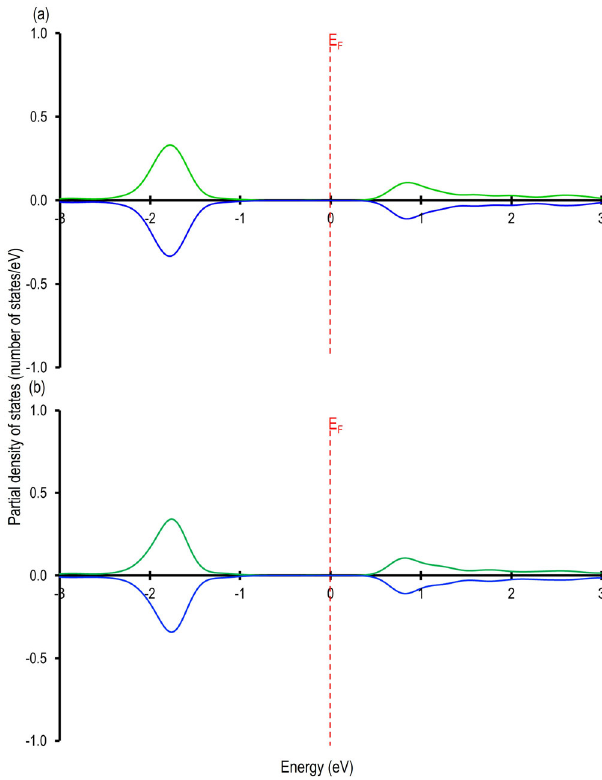
Fig. 5 Partial density of states of Ag-adatom. Partial density of states for Ag-adatom on the 12 membered Si-ring of the ( a ) Si(111)-5×5 and ( b ) Si(111)- 7×7 unit cell. The Fermi energy (E F ) is represented by the dotted line passing through 0eV and the green and blue line represents the up and down spins of the Ag s -orbital signatures respectively. Raw data in ( a ) and in ( b ) is provided in in Supplementary Data 2: ( a ) and ( b ) in